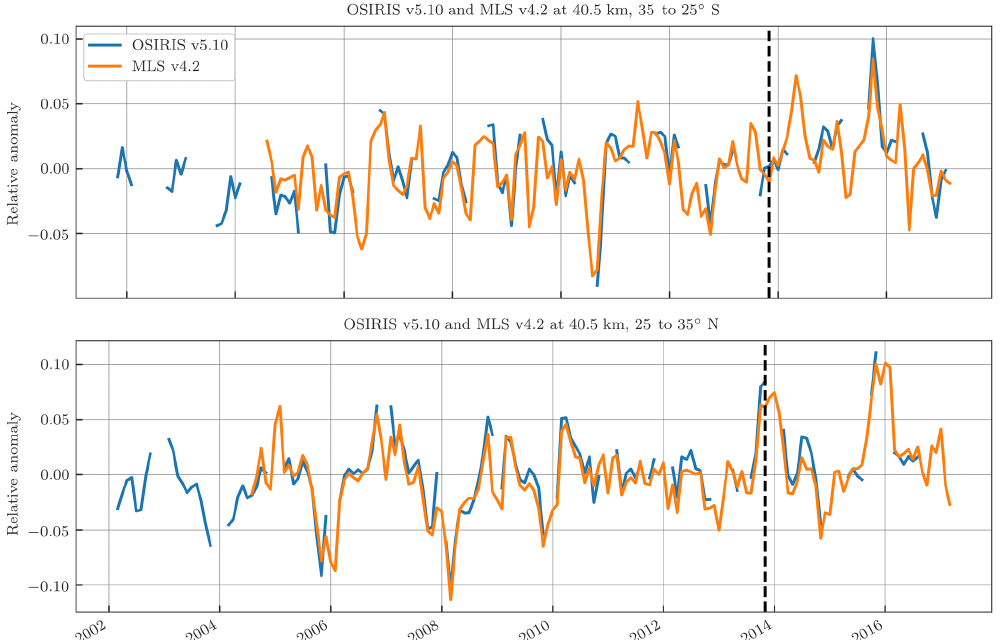
Figure 7. Ozone anomalies used for the trend calculation from pointing-corrected OSIRIS version 5.10, together with the same from MLS at the same locations specified in Fig. 1.